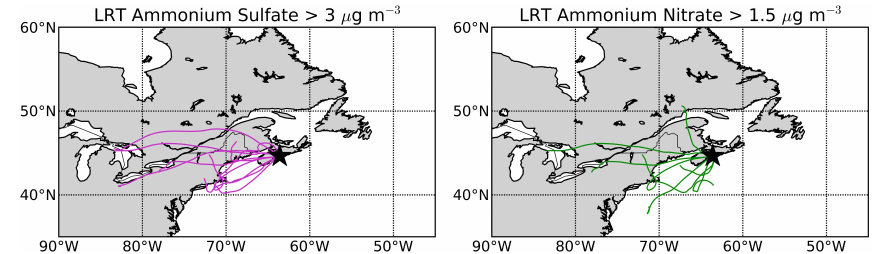
Fig. 11. Back trajectories associated with the highest values of each PMF cluster.